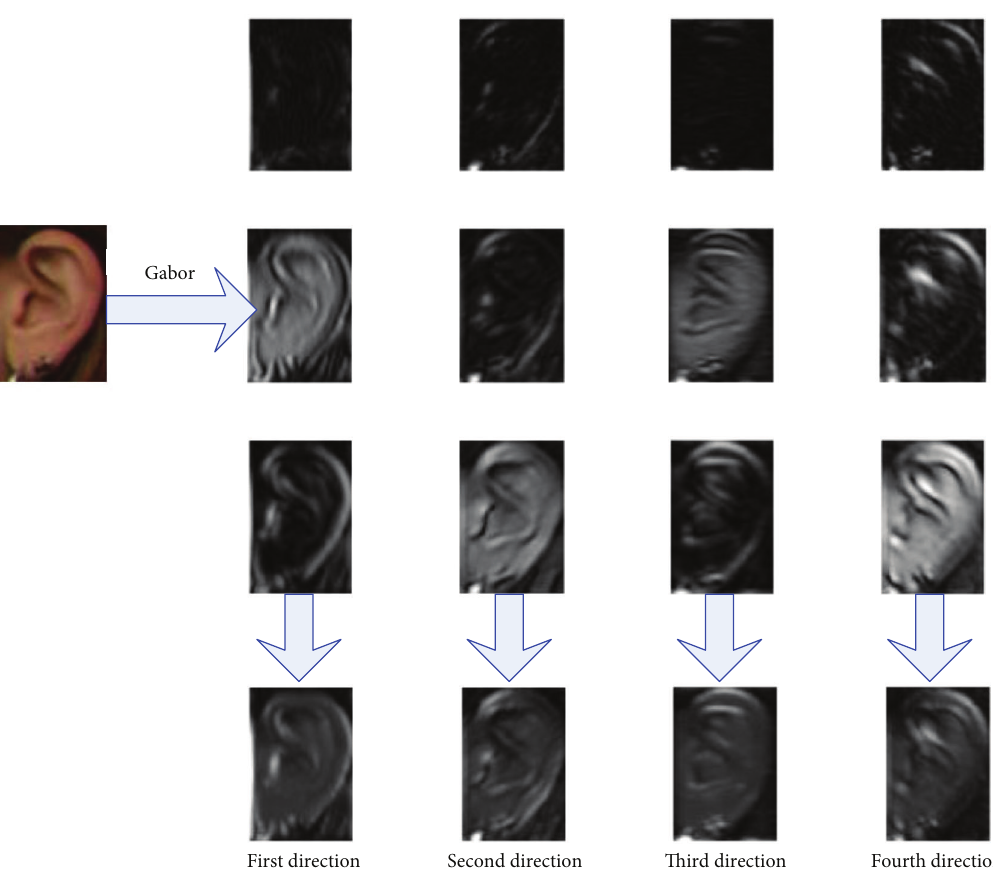
Figure 1: Gabor orientation feature extraction of an ear sample.